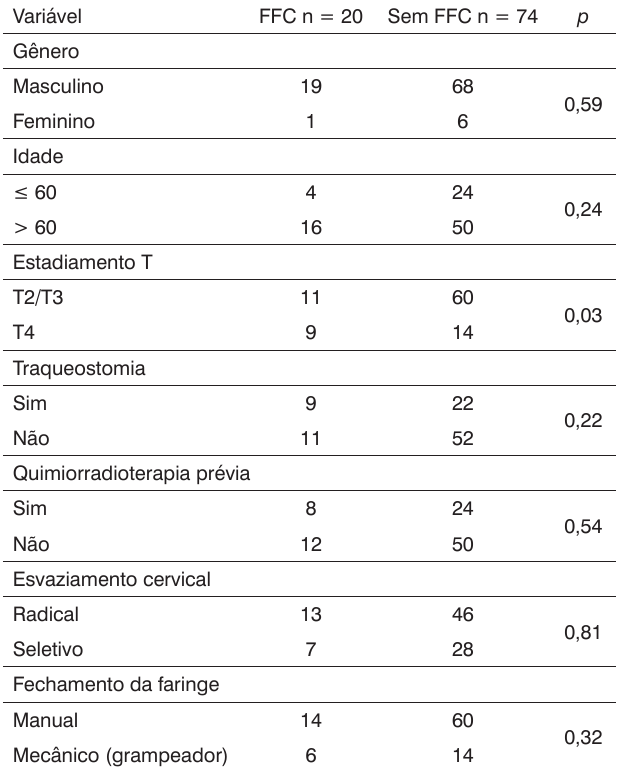
Tabela 1. Relação das variáveis com a incidência de fístula